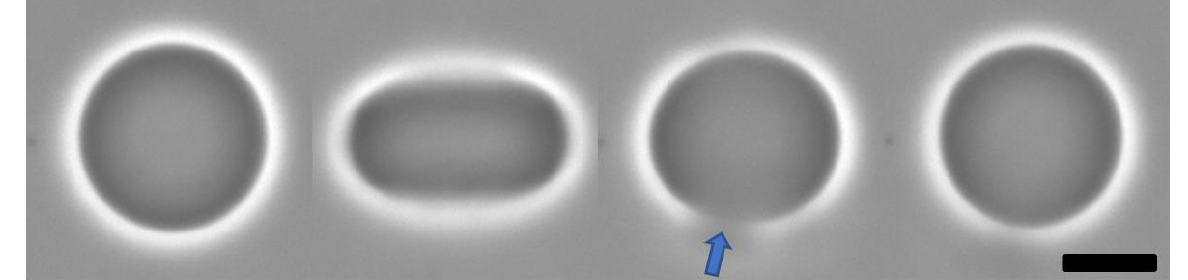
Figure 3. Phase contrast microscopy snapshots showing sequence of electroporation of POPC GUVs in polypeptide – bioparticle solution with deformation produced by electric pulse, pore formation indicated by arrow and final recovery of the spherical shape. All process occurs in less than 100 ms. Bar expands 20 μm for all.